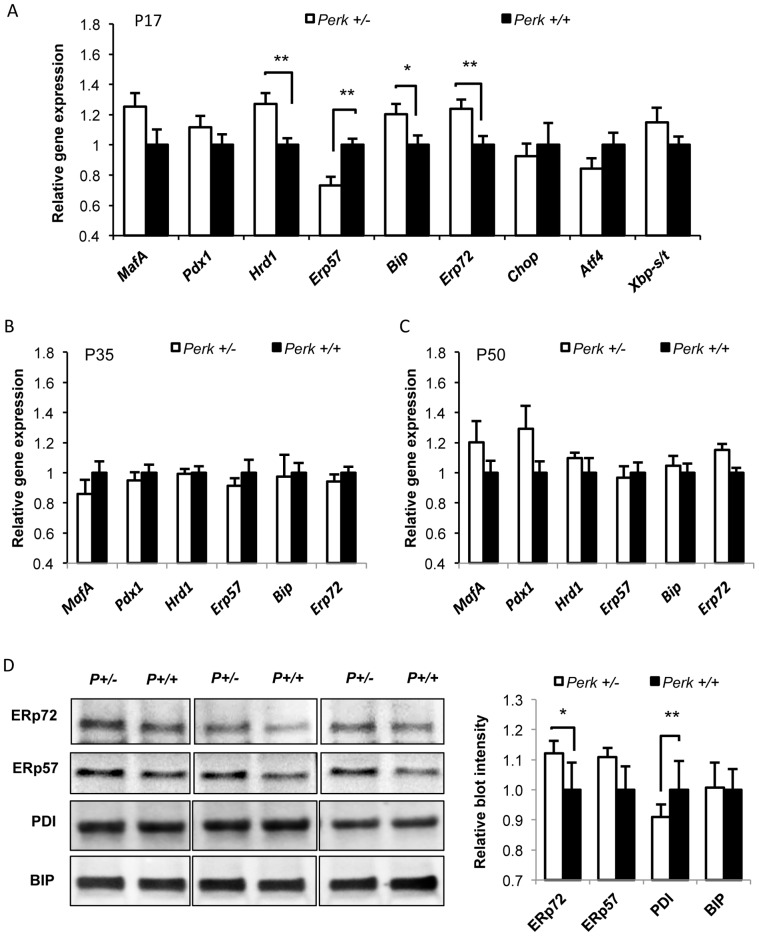
ER chaperones were impacted in P17 Perk+/− mice.A–C. Gene expression levels of mouse islets relative to Perk+/+. Mice are postnatal 17 days (figure A, n = 11,9), 35 days (figure B, n = 8, 8), and 50 days (figure C, n = 4,3). Shown are means ± SEM. (*P<0.05, **P<0.01). D. Western blot analysis of islets isolated from P17 mice. Left panel showed representative blots. Right panel showed quantification of blot intensity in relative to Perk+/+. (n for Perk +/−, Perk+/+  = 5, 5. *P<0.05, **P<0.01).